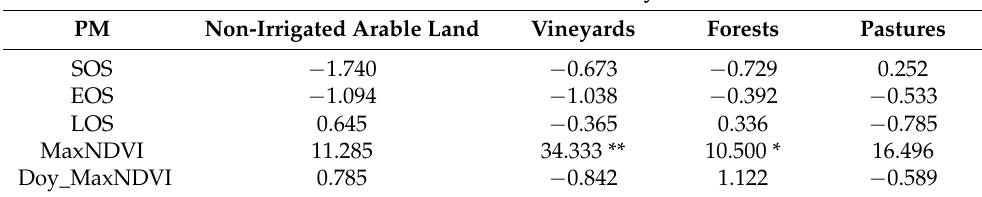
Table 8. Gain values of linear regression trends modelling PMs between 2001 and 2019 for the CLC classes used in this work. *significance level with p- value < 0.05; ** significance level with p- value < 0.01. Gain Values for CLC Classes Analyzed